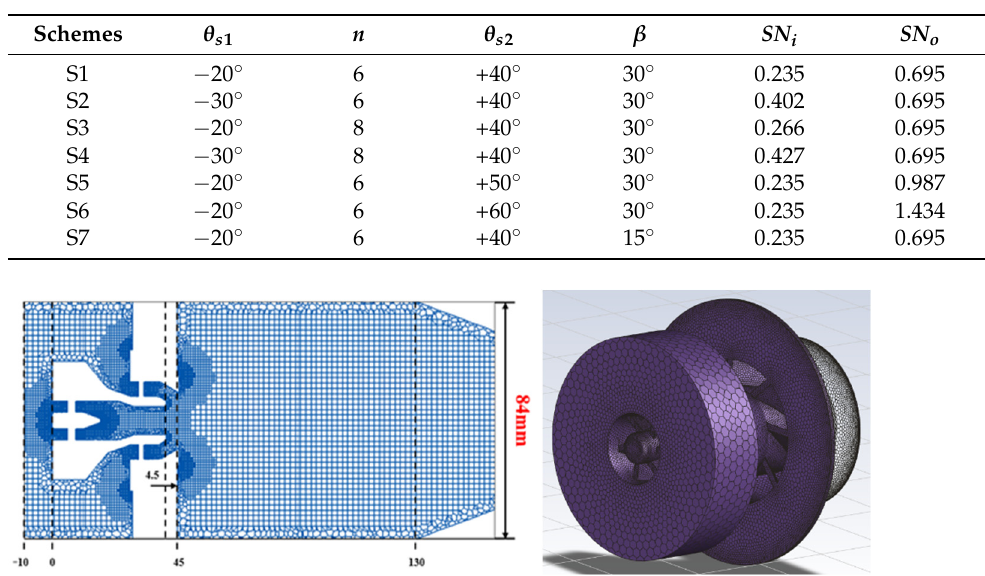
Table 1. Parameters of swirlers.